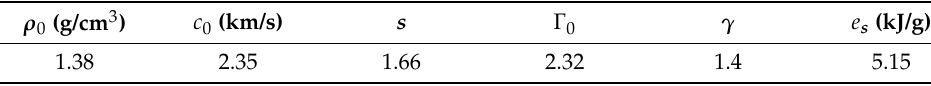
Table 2. State parameters of C/P composites.